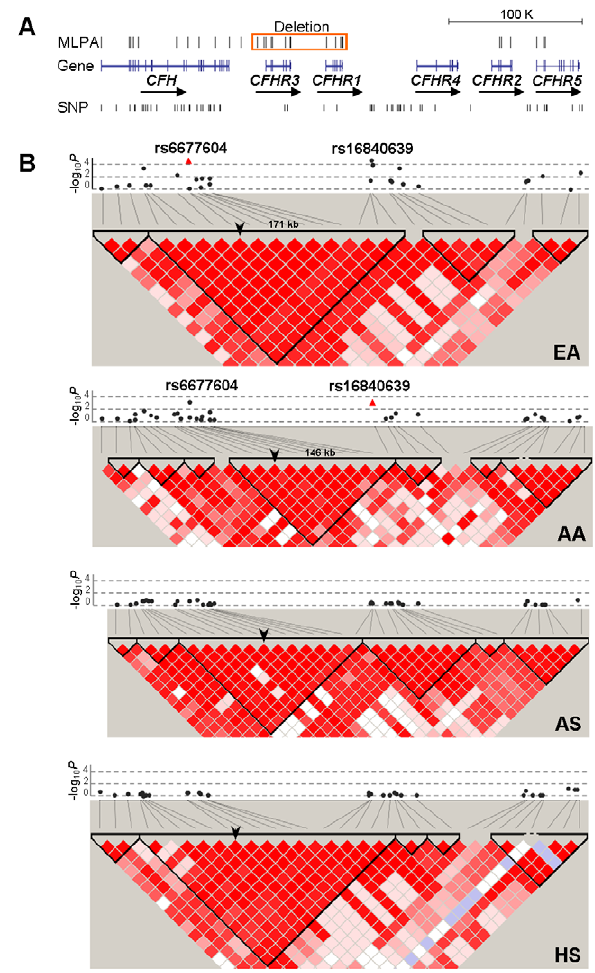
Figure 1. Allelic association of SNPs in the CFH-CFHRs region with SLE and their LD patterns. A) The genomic structure of the CFH-CFHRs region and the location of all SNP and MLPA markers are indicated. The deletion of CFHR3 and CFHR1 detected by MLPA markers is shown as a red box. B) The allelic P value of each SNP with SLE ( 2 log 10 P ) is plotted as a black circle according to its coordinate. The two SNPs exhibiting the strongest association with SLE in EA (rs6677604) and AA (rs16846039) are highlighted as red triangles. SNPs that failed in the HWE testing or showed low genotyping quality are not shown. SNP-constructed haplotype blocks were defined by Haploview using the confidence intervals model. An arrowhead is used to indicate the position of rs6677604 in the haplotype